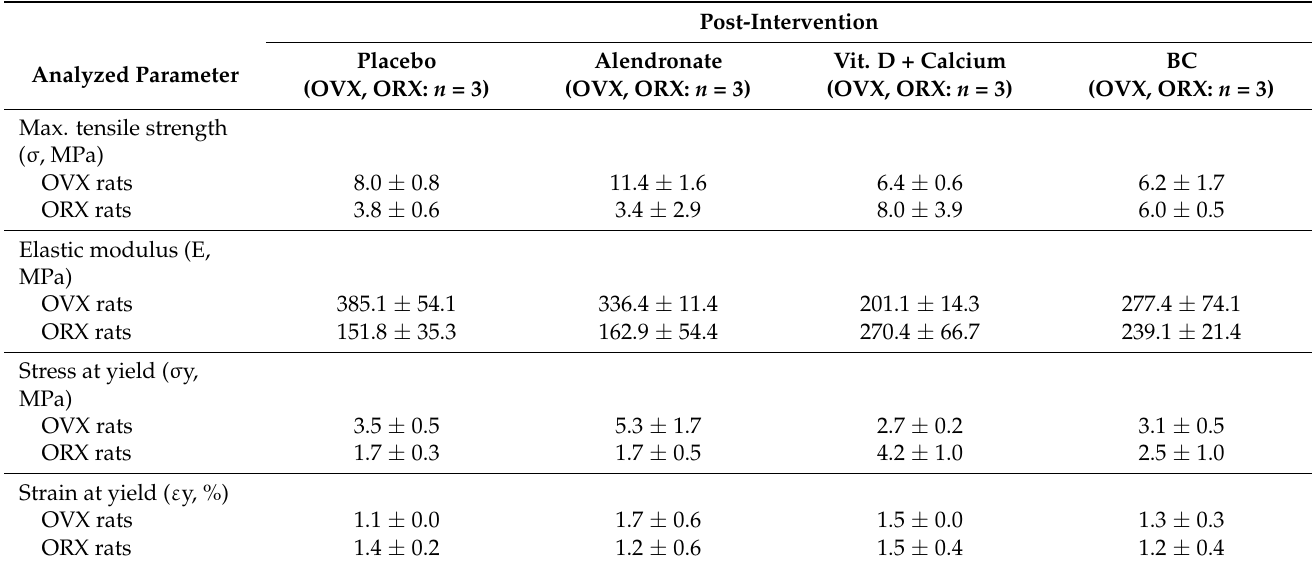
Table 2. Mechanical properties of the OVX and ORX rats’ tibias.